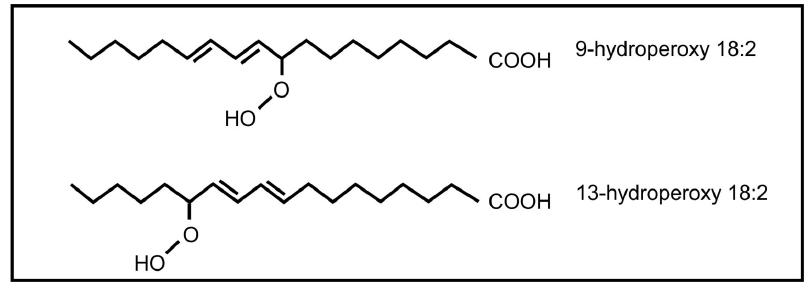
Figure 5. Plant oxylipins involved in communication with